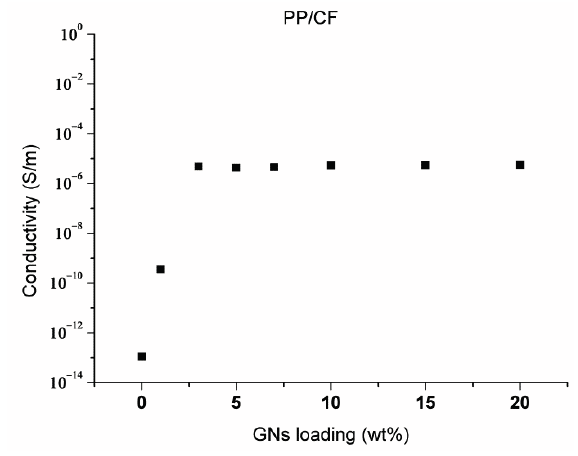
Figure 9. Conductivity of PP/ CF composites as related to various blending